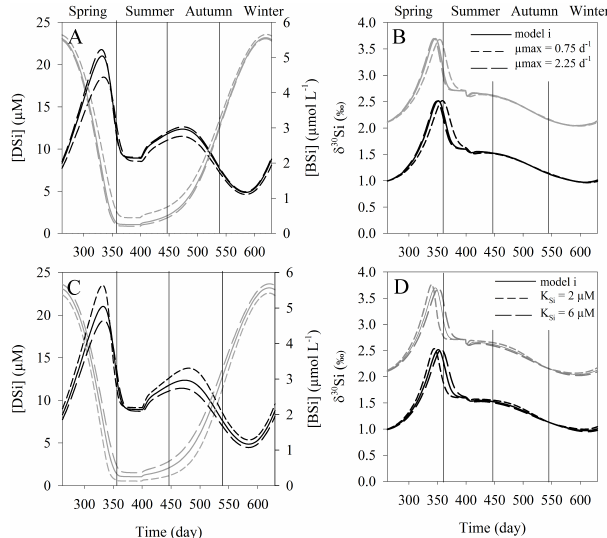
with µ max values ± 50% of the initial value (µ max = 1 . 5d − 1 ) , (C) DSi and BSi concentrations with time for model runs with K Si val- ues ± 50% of the initial value ( K Si = 4µmol-Si), and (B) and (D) δ 30 Si of DSi and BSi versus time for the model runs where µ max (B) and K Si (D) were tested. Black: BSi, grey: DSi, solid line: ini- tial run, dashed lines: values